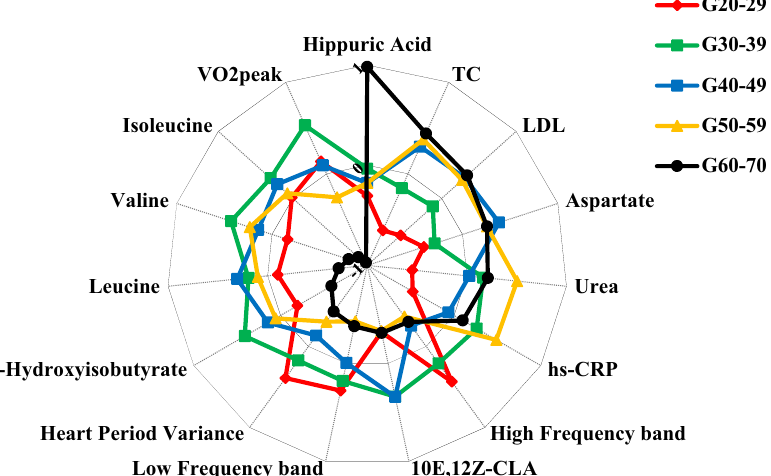
Figure 3. Characterization of each age group according to the significant variables. Data presented by z-score mean values of each age group for each variable. 10E,12Z-CLA 10E,12Z-octadecadienoic acid, G 20–29 20–29 years cholesterol, VO 2PEAK peak oxygen